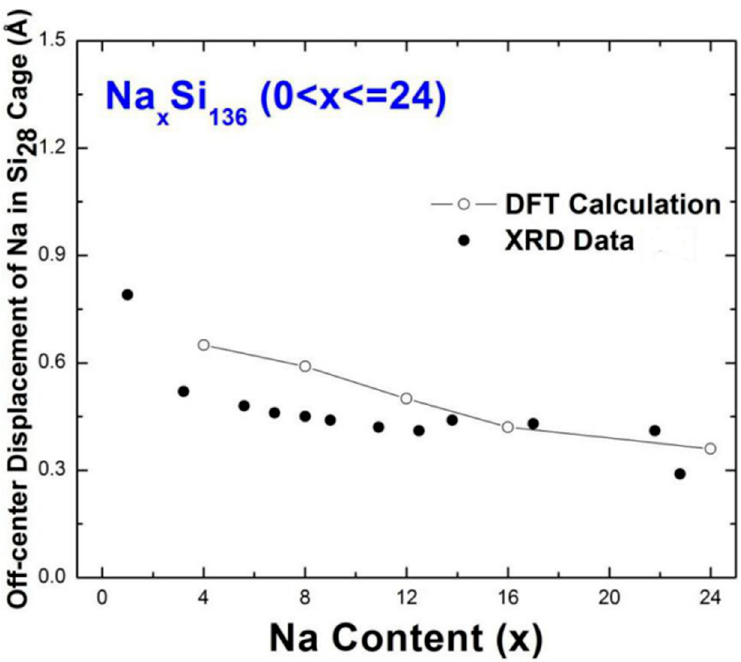
Figure 5. DFT-calculated “off-center” displacements (open circles) of Na in the Si 28 cages in Na x Si 136 as a function of Na composition ( x = 4, 8, 12, 16, 24), along with XRD measured displacements (solid dots) by Beekman et al. [31].